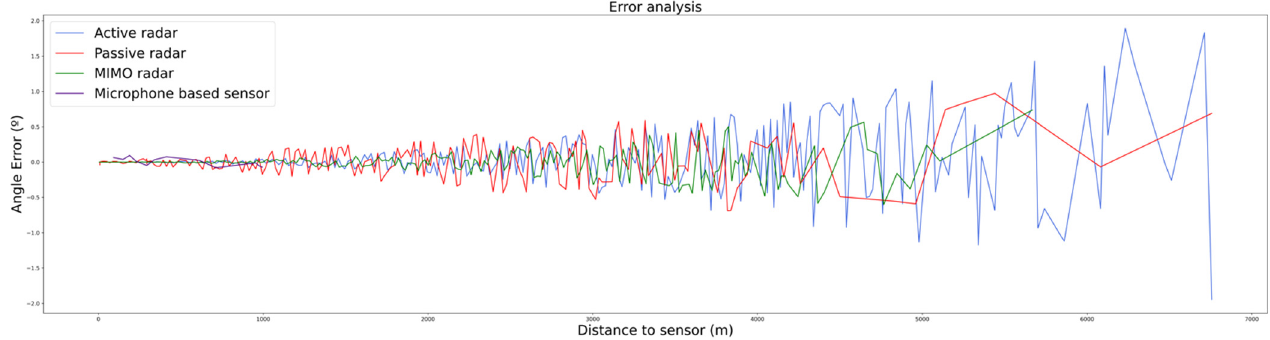
incoming drone. Figure 6. Plots generated by MIMO and microphone-based sensors corresponding to the actual